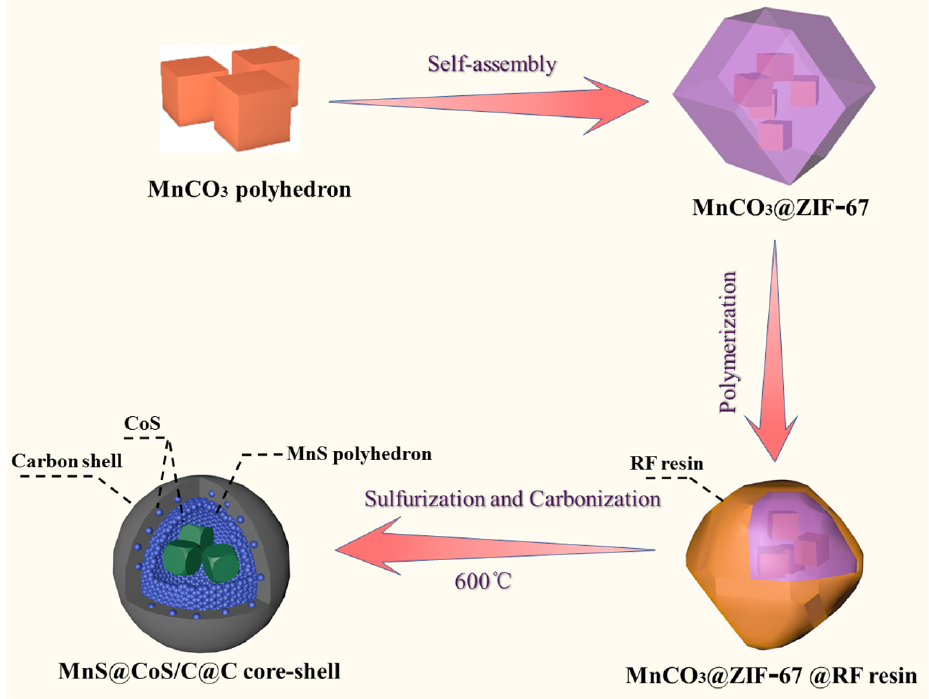
Figure 1. Synthetic procedure for the preparation of MnS@CoS/C@C nanocapsules. Figure 2a,b show SEM and TEM images of MnCO 3 nanopolyhedrons. MnCO 3 nanopolyhedrons present solid structure, uniform size and sharp edges. Although the